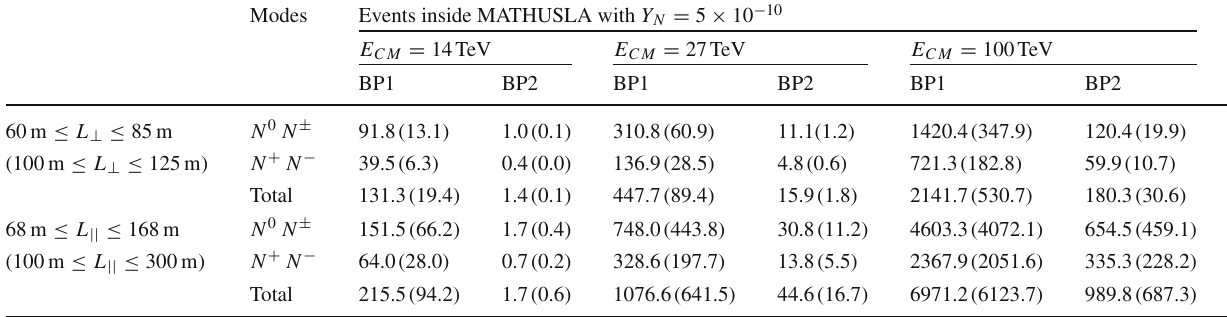
Table 5 The observed number of events in MATHUSLA detector in transverse and longitudinal direction for all benchmark points, with Y N = 5 × 10 − 10 at the centre of mass energies of 14, 27 and 100 TeV at